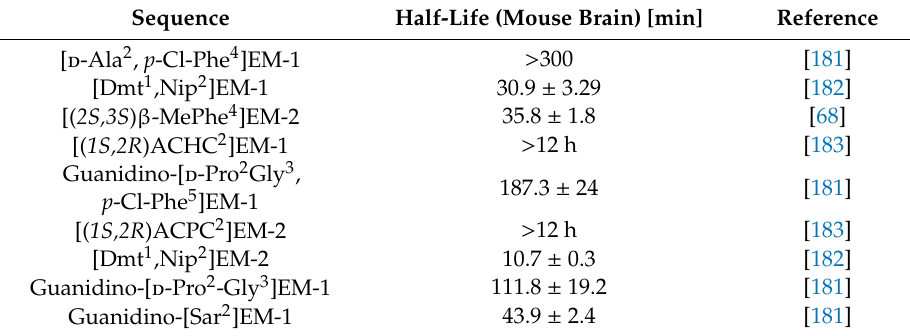
Table 7. Stability half-life of opioid